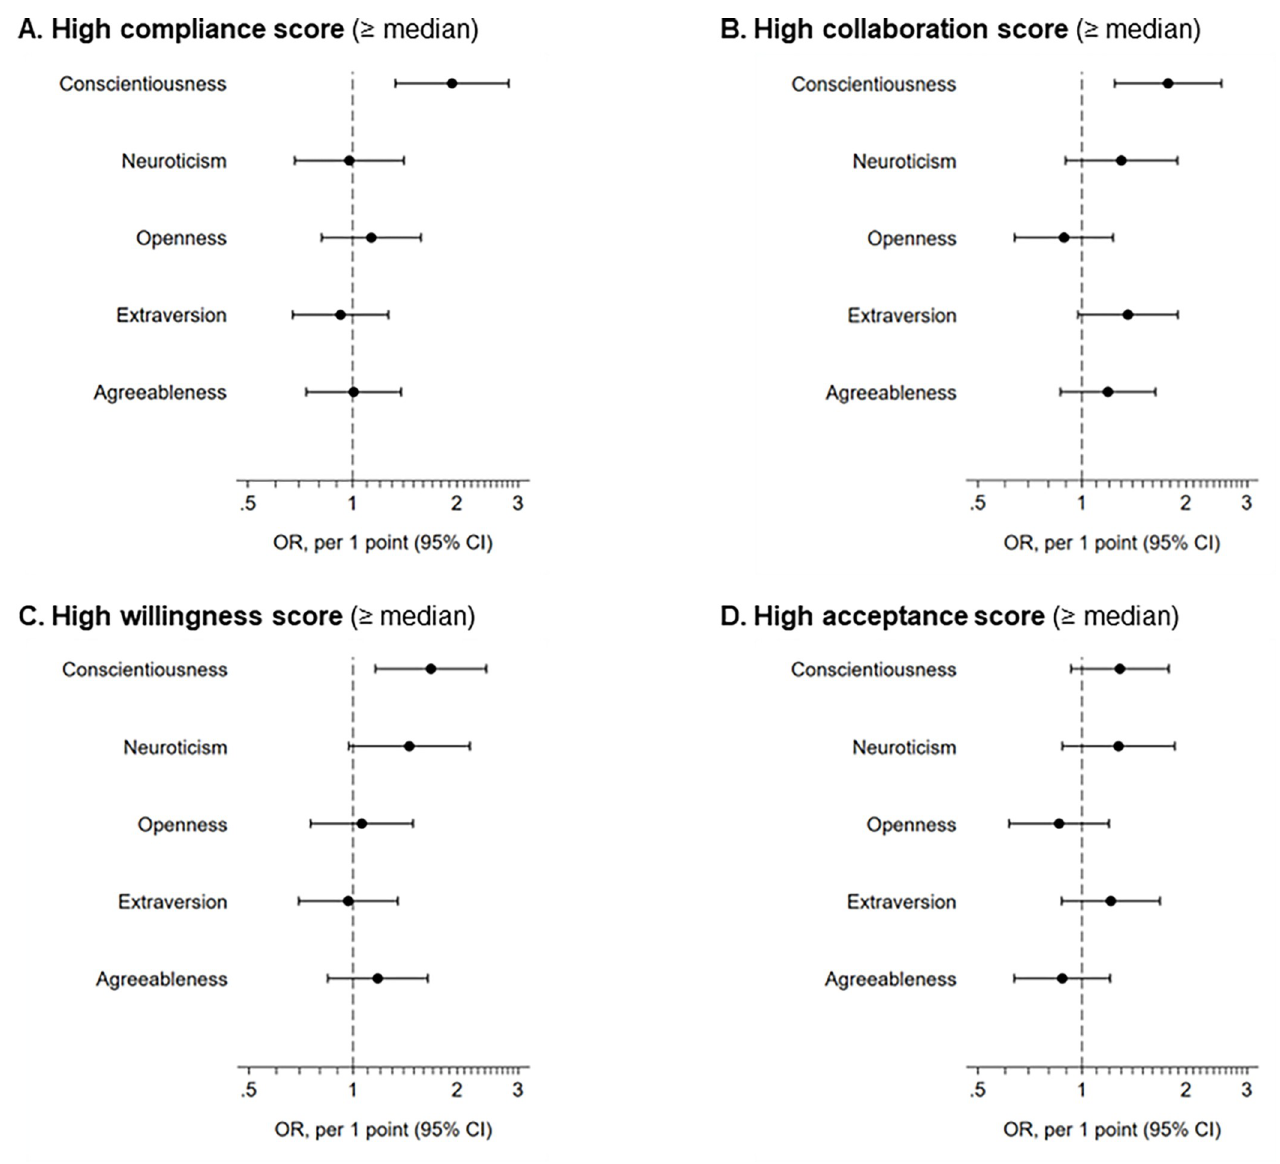
Fig 2. Results of age-adjusted logistic regression analysis. OR, odds ratio; CI, confidence interval.